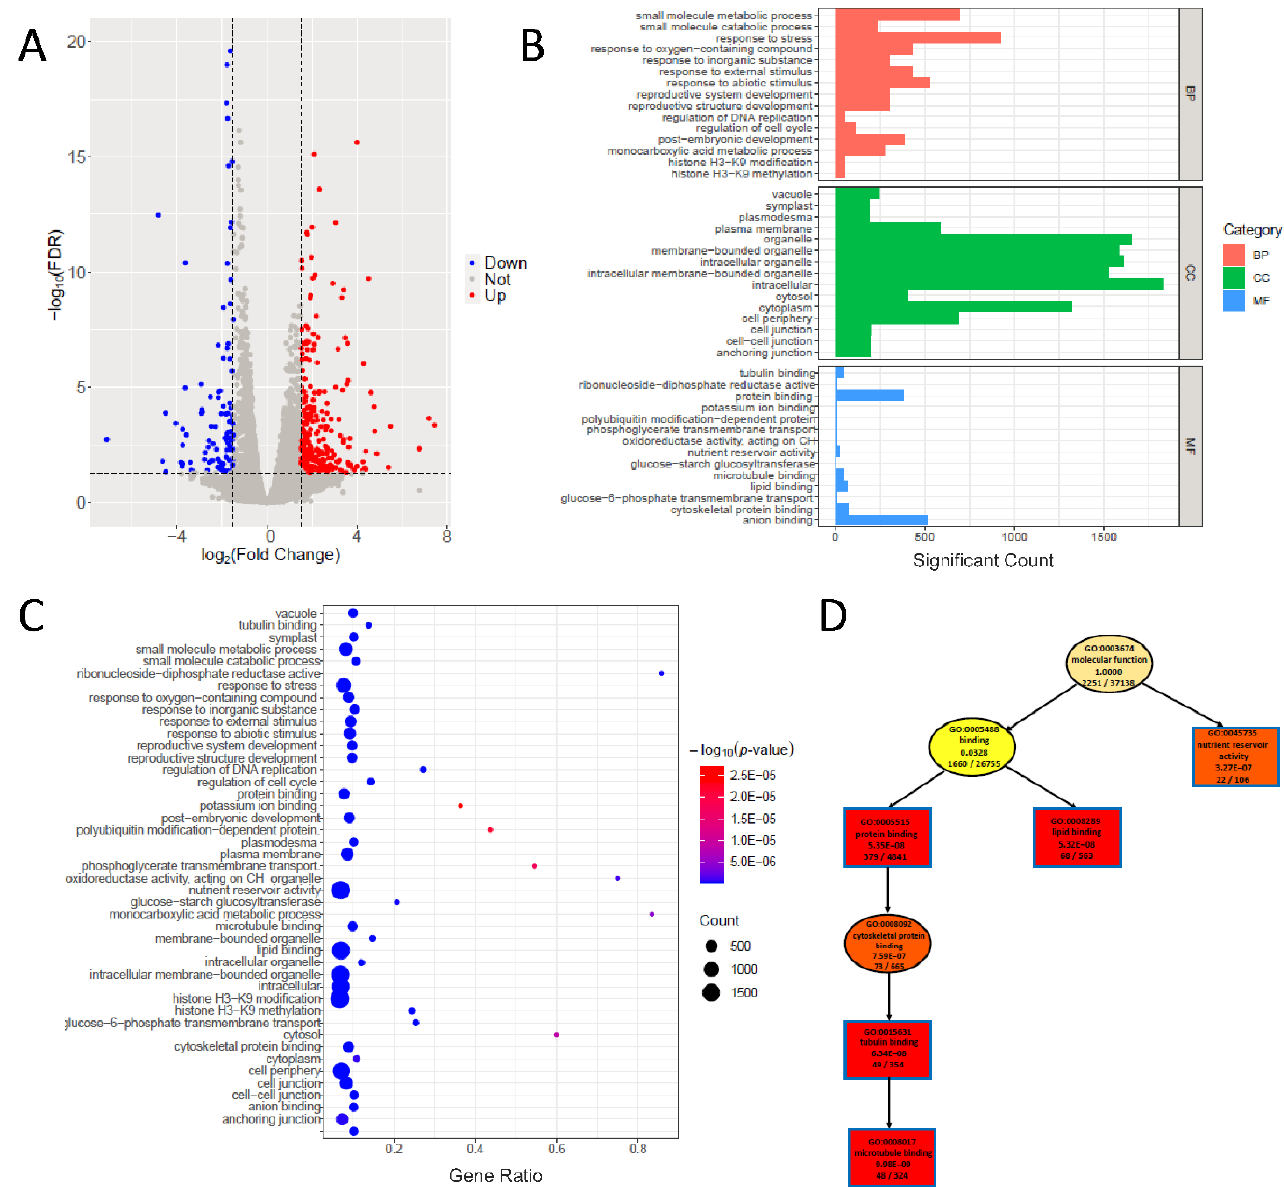
Figure 3. Differential expression analysis and GO analysis for the maize small-kernel mutant. ( A ) The volcano plot shows the DEGs for the maize small-kernel mutant, and the analysis was performed by using “DEG_analysis()”. ( B ) The histogram shows the result of GO analysis of differentially expressed genes for the maize small-kernel mutant, and the analysis was performed by using “GO_analysis()”. The top 20 terms of each mode (“BP”, “CC”, “MF”) are shown in this plot. ( C ) A part of the directed acyclic plot drawn using the “MF” mode of “GO_analysis()”. ( D ) Bubble plot shows the result of GO analysis, and the GO terms are the same as in ( B ).